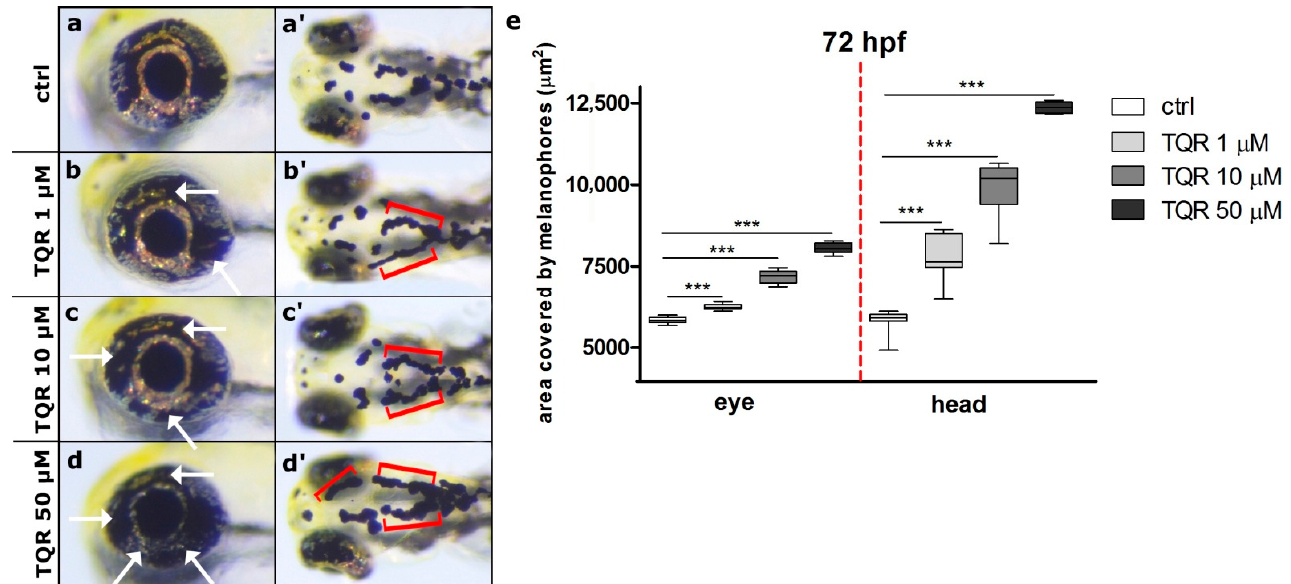
Figure 2. Dose-dependent increase in zebrafish melanophore pigmentation following the exposure to tariquidar (TQR) at 72 h post fertilization (hpf). A set of photographs presenting lateral and dorsal views of 72 hpf zebrafish larvae exhibiting effects of 68-h TQR exposure on the melanophore pigmentation within the eye and dorsal head in four experimental groups: ( a,a’ ) control, (b,b’ ) exposed to TQR 1 µM ( c, c’ ) exposed to TQR 10 µM, and ( d,d’ ) exposed to TQR 50 µM. Control larvae presented normal melanophore distribution within both the eye and dorsal head ( a , a’ ). Progressive hypermelanogenesis was observed as the concentration increased ( b, b’; c, c’; d, d’ ). In the area of the eye, the melanophores started to occupy the area normally covered by the iridophores ( b,c,d ) (white arrows). Within the dorsal head in the control group, the melanophores were separated, while in the TQR exposed groups, they began to merge and form closely apposed groups ( b’,c’,d’ ) (red buckle). ( e ) A graph presenting the area covered by melanophores (µm 2 ) measured at 72 h post fertilization (hpf) within the eye and dorsal head (one-way ANOVA/Kruskal–Wallis, GraphPad Prism 5, *** p < 0.001).